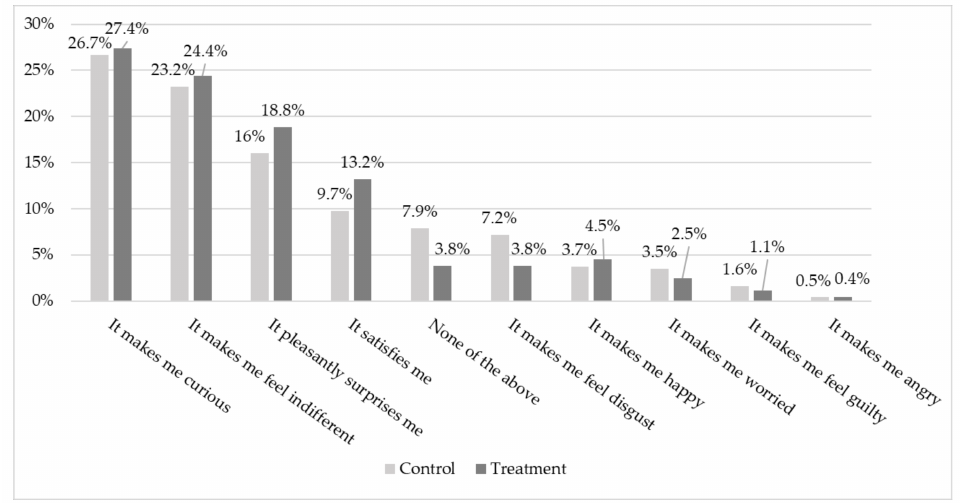
Figure 3. Frequency of emotional terms reported by treatment. Pearson’s chi-squared (df) = 16,625 (9), p =